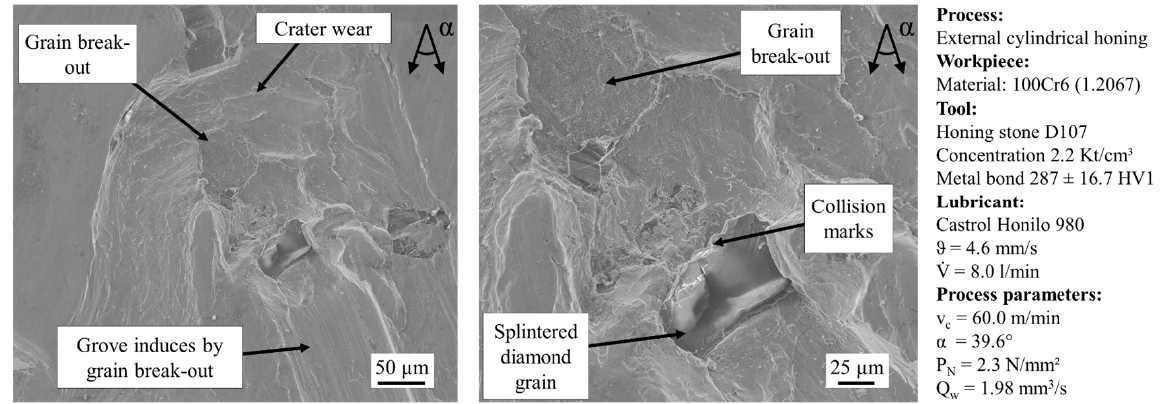
Figure 8. Bond wear in form of grooves induced by grain break-out.